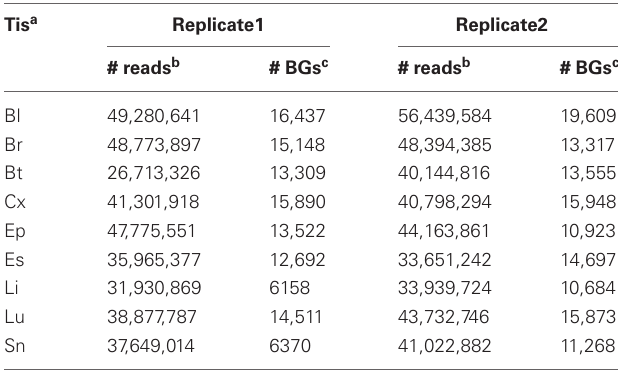
Table 2 | The ENCODE dataset is comprised of short-reads from 18 RNA-seq experiments performed on nine human tissues with each having two replicates.